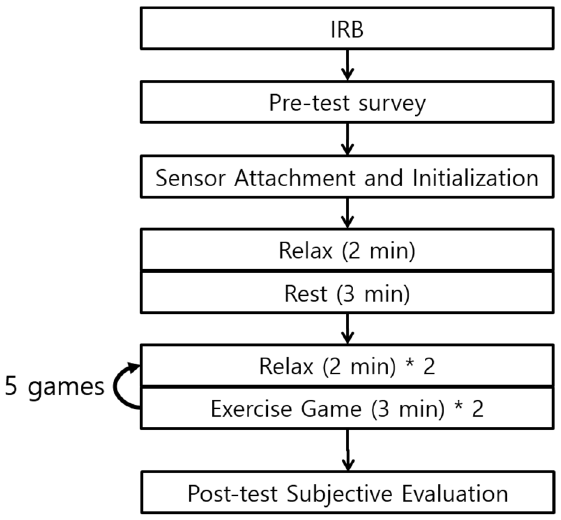
Figure 1. The experimental procedure.